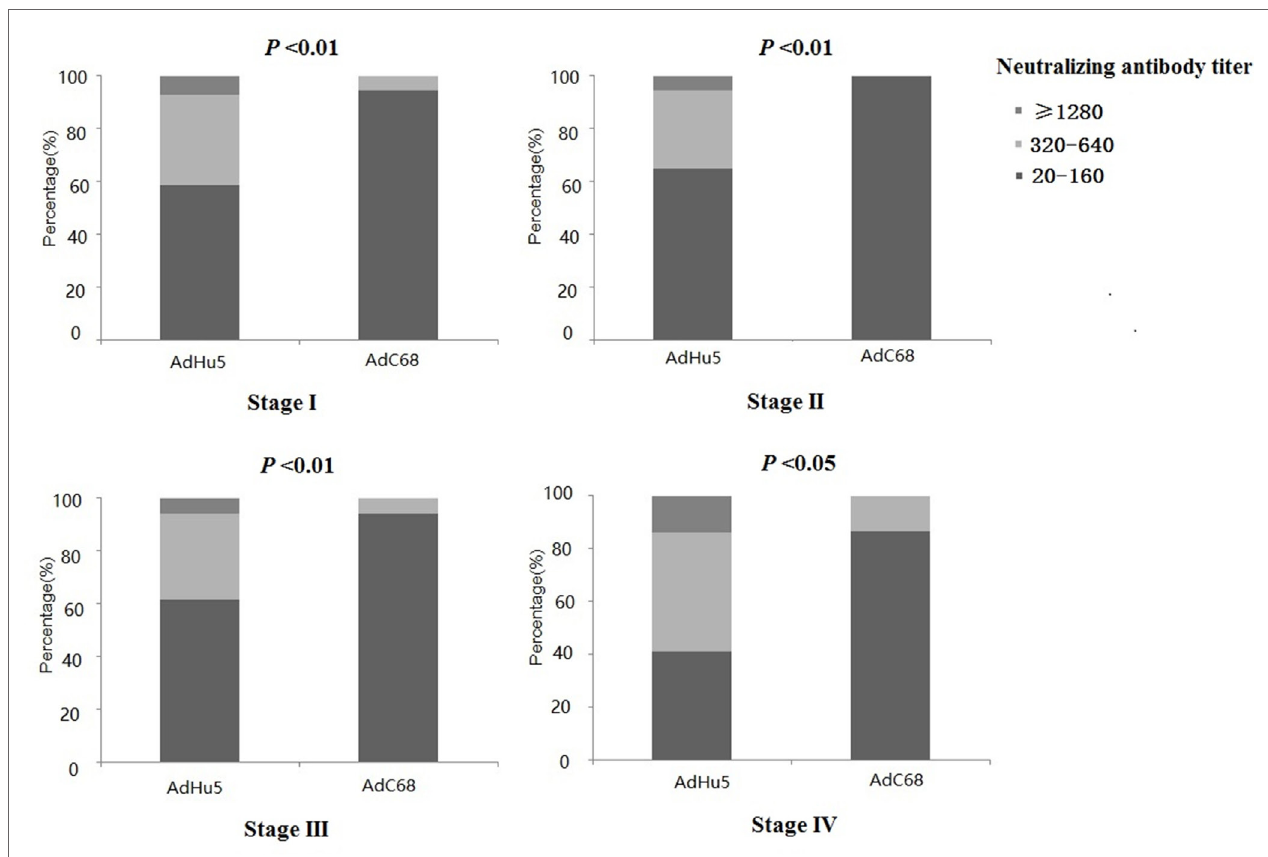
FigUre 2 | Distribution of AdHu5 and AdC68 neutralizing antibody (NAb) titers in positive samples from cancer patients in different clinical stages. NAb titers were stratified in the following tiers: low titer ( ≥ 20 and ≤ 160), medium titer ( ≥ 320 and ≤ 640), and high titer ( ≥ 1,280). For stage-I positive subjects, the AdHu5 NAb titers from low to high were 58.54, 34.15, and 7.32%, respectively, whereas the AdC68 NAb titers from low to high were 94.55, 5.45, and 0%, respectively; a significant difference existed between the AdHu5 NAb and AdC68 NAb titers among stage-I positive subjects ( P < 0.01). For stage-II positive subjects, the AdHu5 NAb titers from low to high were 64.81, 29.63, and 5.56%, respectively, while all of the positive AdC68 NAb sample titers were lower or equal to 160. For stage-III positive subjects, the AdHu5 NAb titers from low to high were 61.45, 32.53, and 6.02%, respectively. However, most cancer patients exhibited low NAb titers against AdC68 ( ≥ 20 and ≤ 160, 94.12%), and a small fraction of cancer patients exhibited a medium level of AdC68 NAb titers ( ≥ 320 and ≤ 640, 5.88%). For stage-IV positive subjects, the AdHu5 NAb titers from low to high were 40.91, 45.45, and 13.64%, respectively, while the AdC68 NAb titers from low to high were 86.67, 13.33, and 0%, respectively; this was significantly different from AdHu5 ( P <